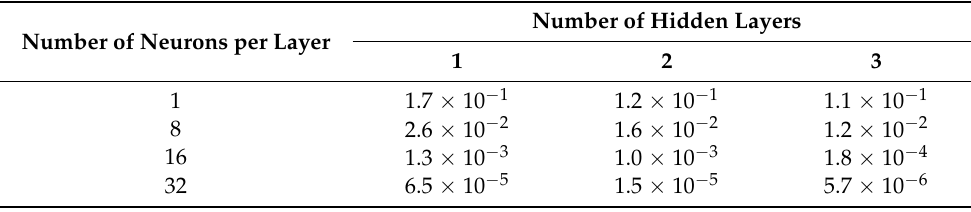
Table 4. Total model losses for different architectures for the heat exchanger network. Number of Neurons per